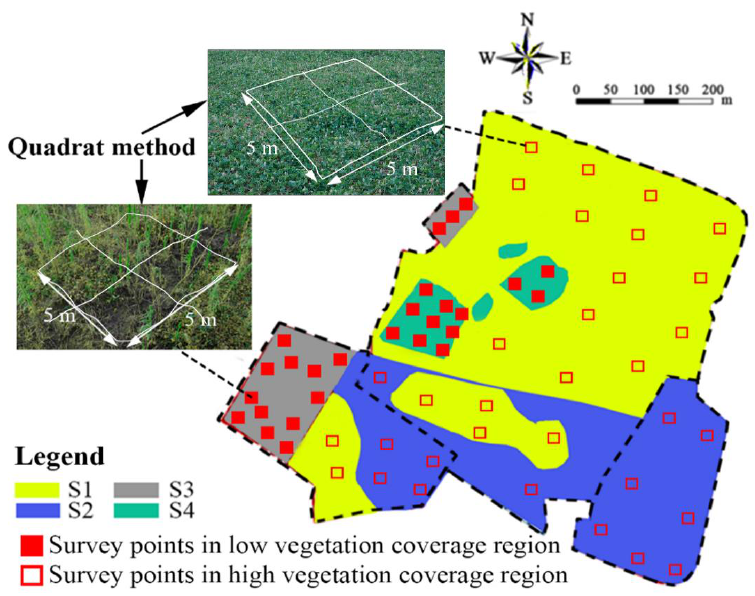
Figure 4. The selection of the investigation points for the CCC cracking.